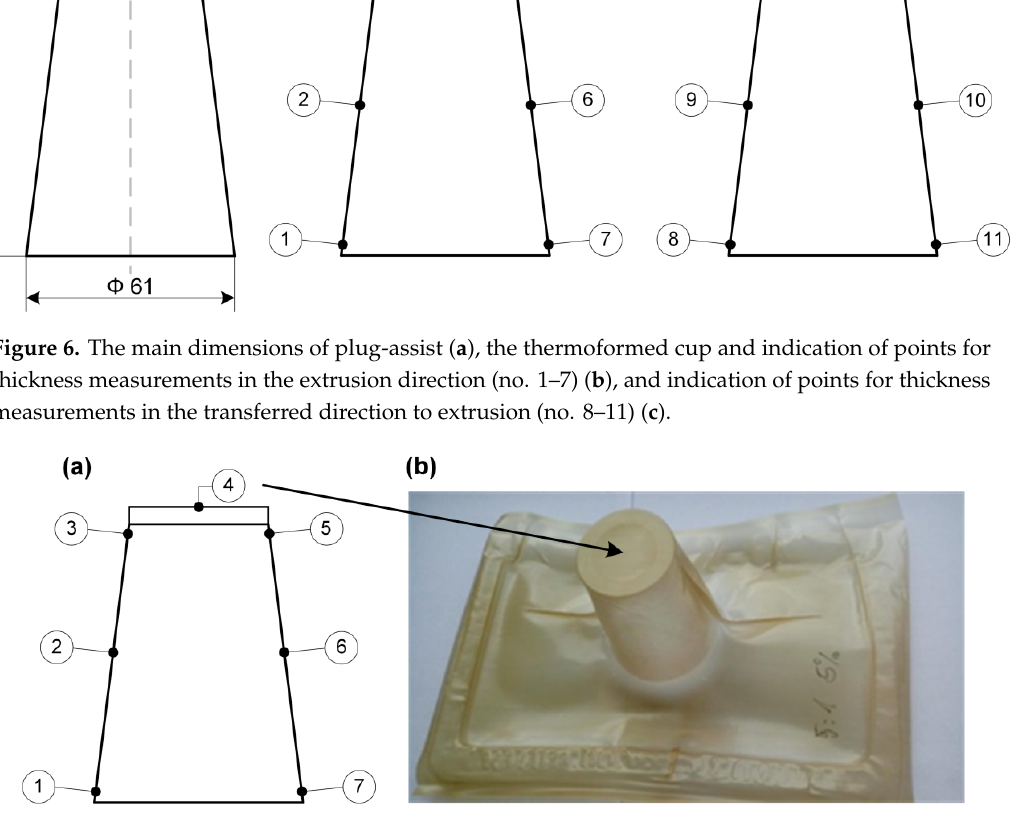
Table 2. Percentage contributions of relative wall thicknesses related to point no. 4. Measurement Points Samples Used for Thermoforming